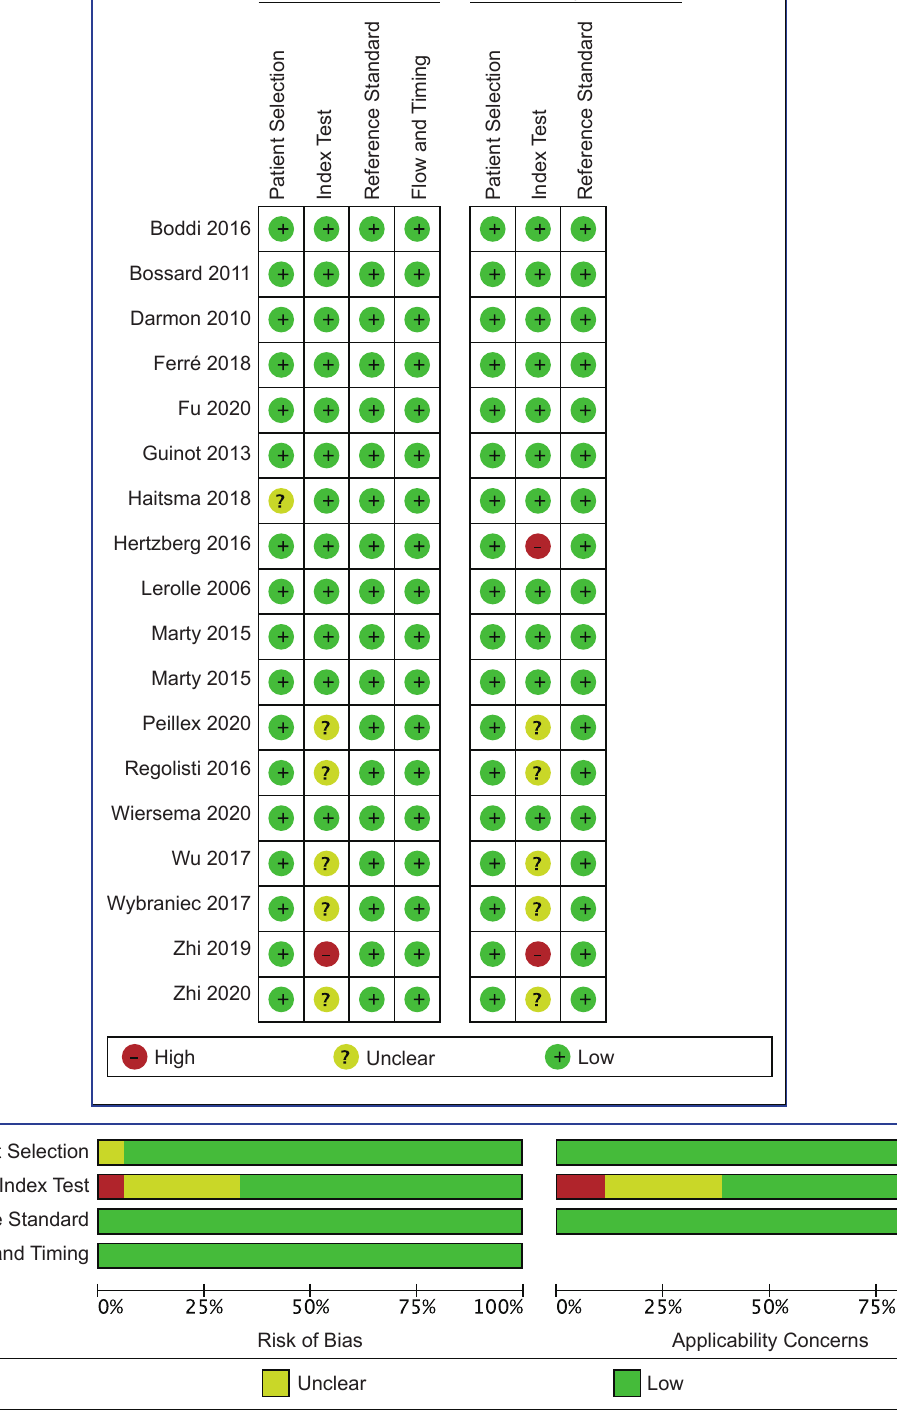
Figure 5 Summary of the methodological quality of the studies according to the QUADAS-2 criteria to have a positive test result than is a healthy person (Fig. 3). Given a pretest probability of 50%, the post- test probability for a positive test result is 76% (Fig.